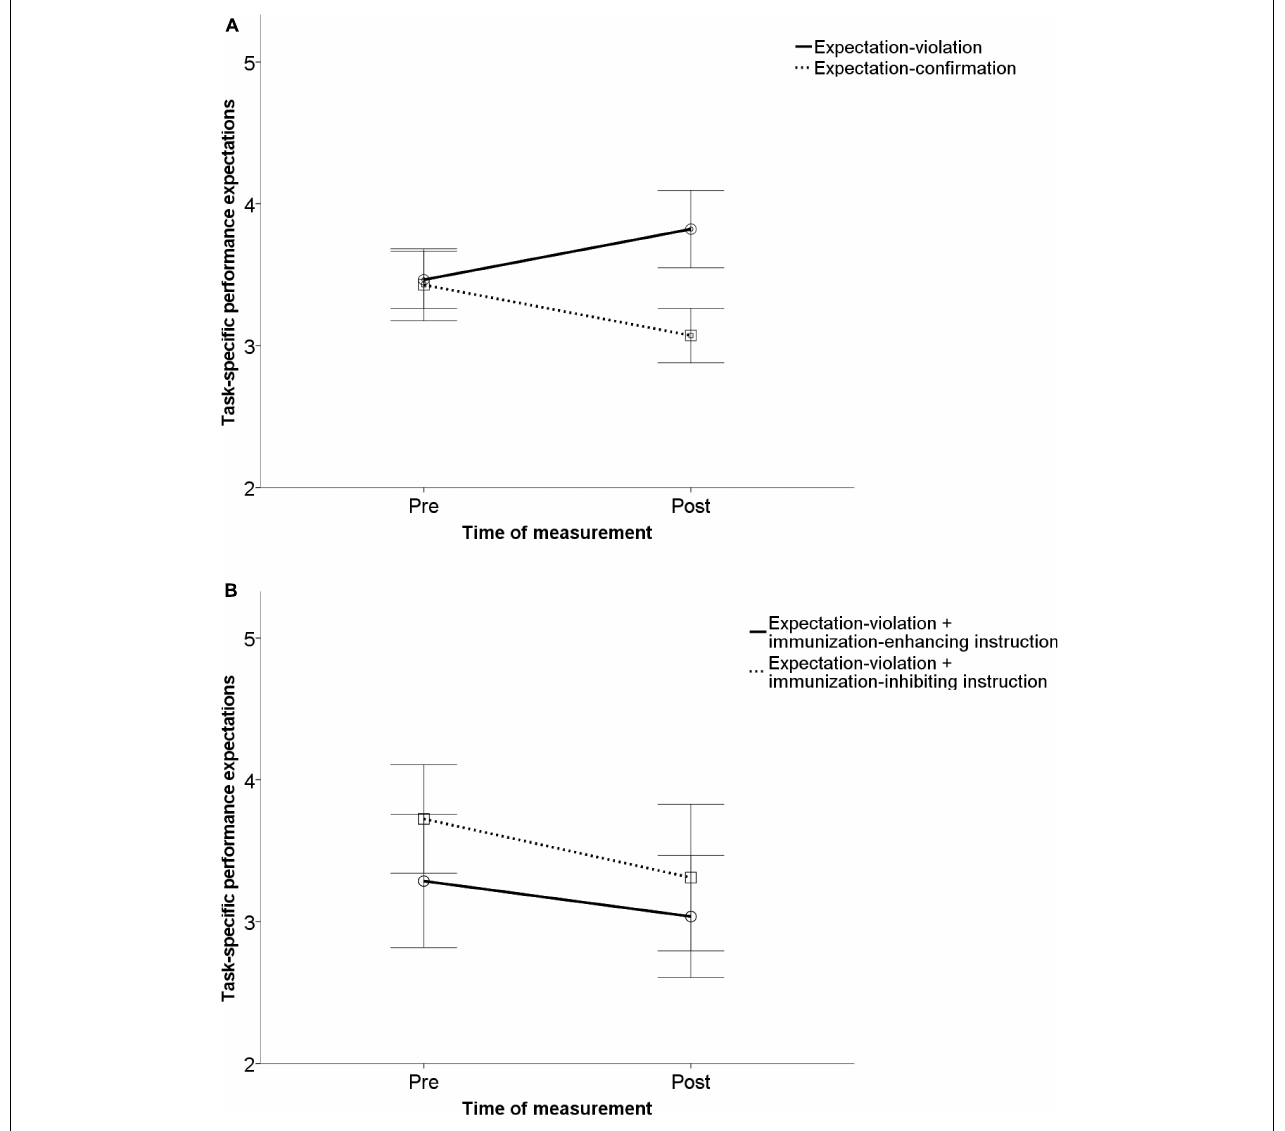
FIGURE 4 | Illustration of the main results for specific expectation change. Experiment 1 (A) : Results indicated that after receiving expectation-confirming performance feedback, participants did not change their task-specific performance expectations significantly. In the expectation disconfirmation condition, participants significantly changed their task-specific expectations. Experiment 2 (B) : No significant change of task-specific expectations occurred after immunization-inhibiting or -enhancing instructions. The error bars represent one standard